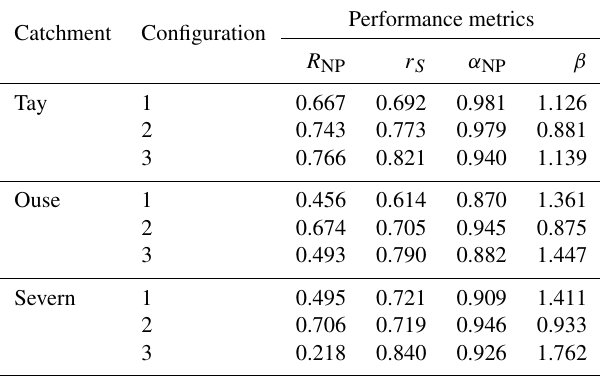
Table 3. Quantitative comparison of the three configurations for the three study catchments. Catchment